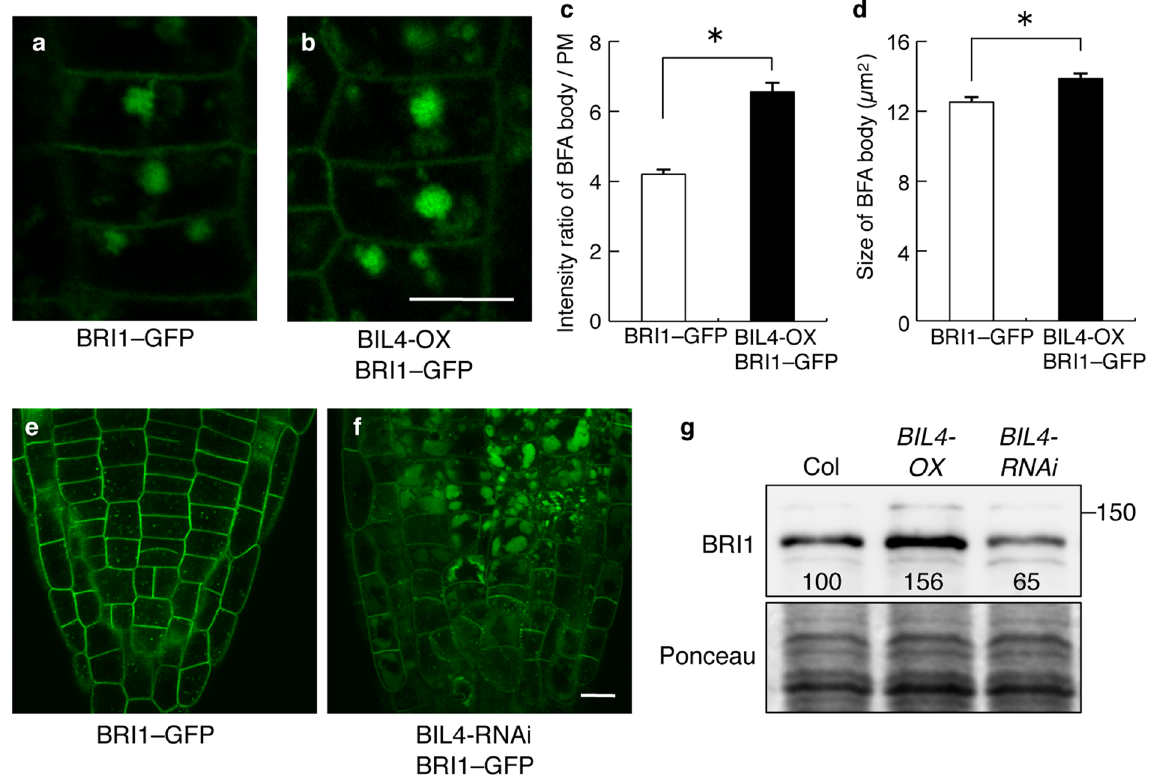
Figure 6. BRI1 subcellular localization is affected in the BIL4-OX and BIL4-RNAi plants. ( a–d ) Three-day- old seedlings were treated with BFA (50 μ M, 0.5 hr). BRI1–GFP-labeled BFA bodies in the wild-type ( a ) and BIL4-OX plants ( b ). Scale bar, 10 µ m. Signal intensities of BRI1–GFP-labeled BFA bodies in the wild-type and BIL4 - OX plants ( c ). Sizes of BRI1–GFP-labeled BFA bodies in the wild-type and BIL4-OX plants ( d ). ( c,d ) n = 3 roots with at least 30 BFA bodies. * P < 0.01, Student’s t -test. Mean ± s.e. ( e , f ) BRI1–GFP localization in the root tip of wild-type ( e ) and BIL4-RNAi mutant ( f ) 2 days after germination in the dark. Scale bar, 10 µ m. ( g ) Plants were grown in the dark for 7 days on medium containing 3 µ M Brz. Western blot analyses were performed using the anti-BRI1 antibody (upper panel). The protein levels were detected using Ponceau S (lower panel). Numbers indicate the relative BRI1 signal levels normalized to the Ponceau S-stained protein